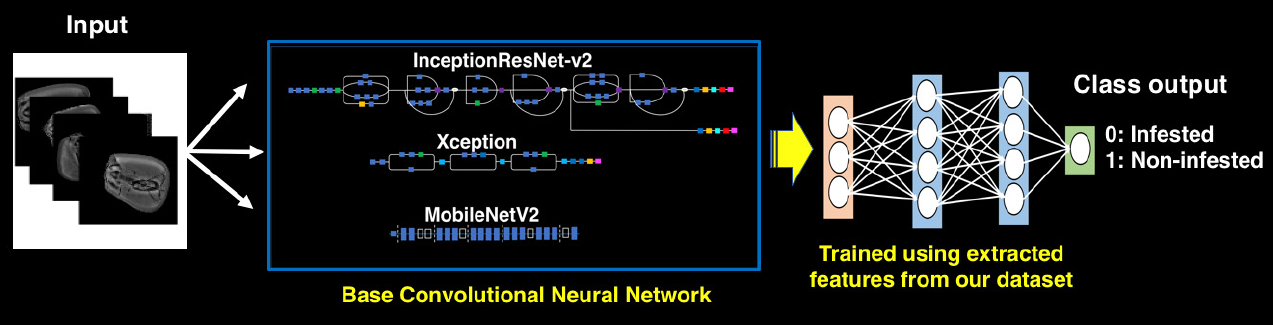
Figure 2. Outline of the convolutional neural network models developed for X-ray image classification of maize grains infested and non-infested with Sitophilus zeamais using the Inception-ResNet-v2, Xception and MobileNetV2 architectures.